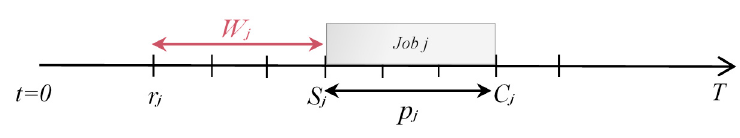
Figure 1. The waiting time of job j .